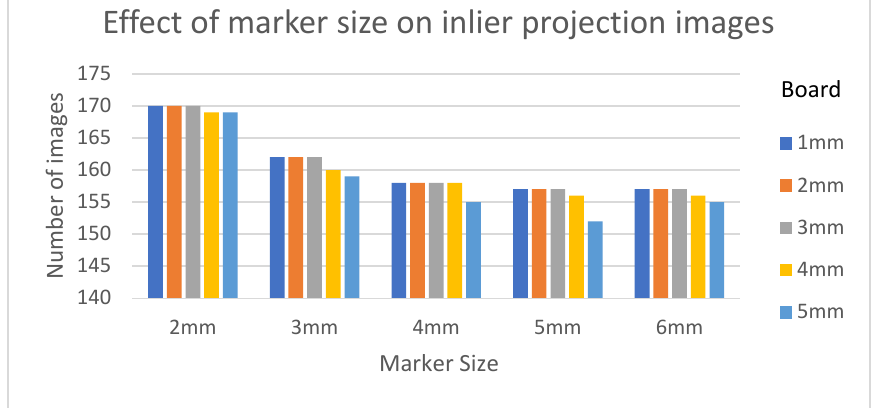
Figure 10. The number of inlier projection images as the size of the planar marker and calibration board thickness changes.